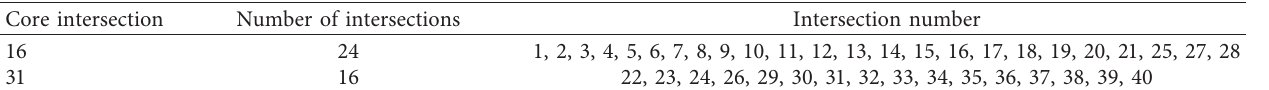
Table 2: Static partition results of the first subzone.